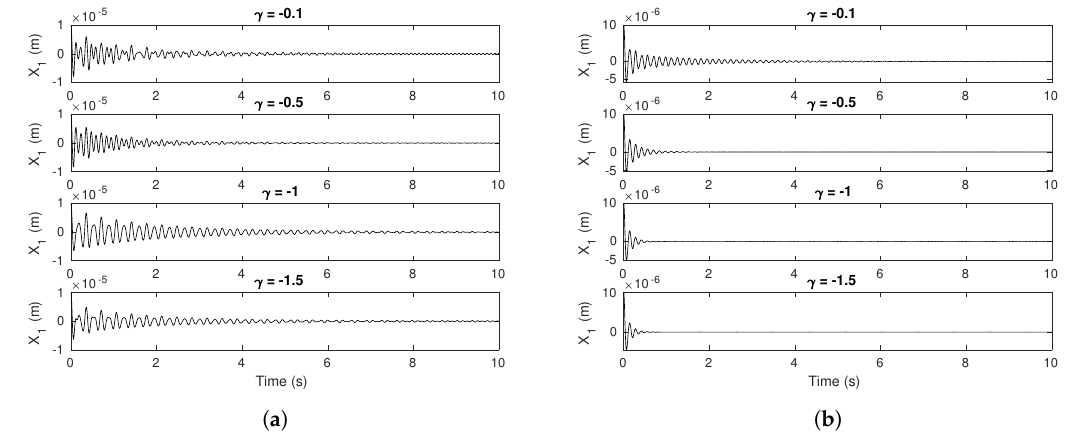
Figure 11. Influence of the control gain γ on controlled X 1 . ( a ) µ = 0.4. ( b ) µ = 0.7.